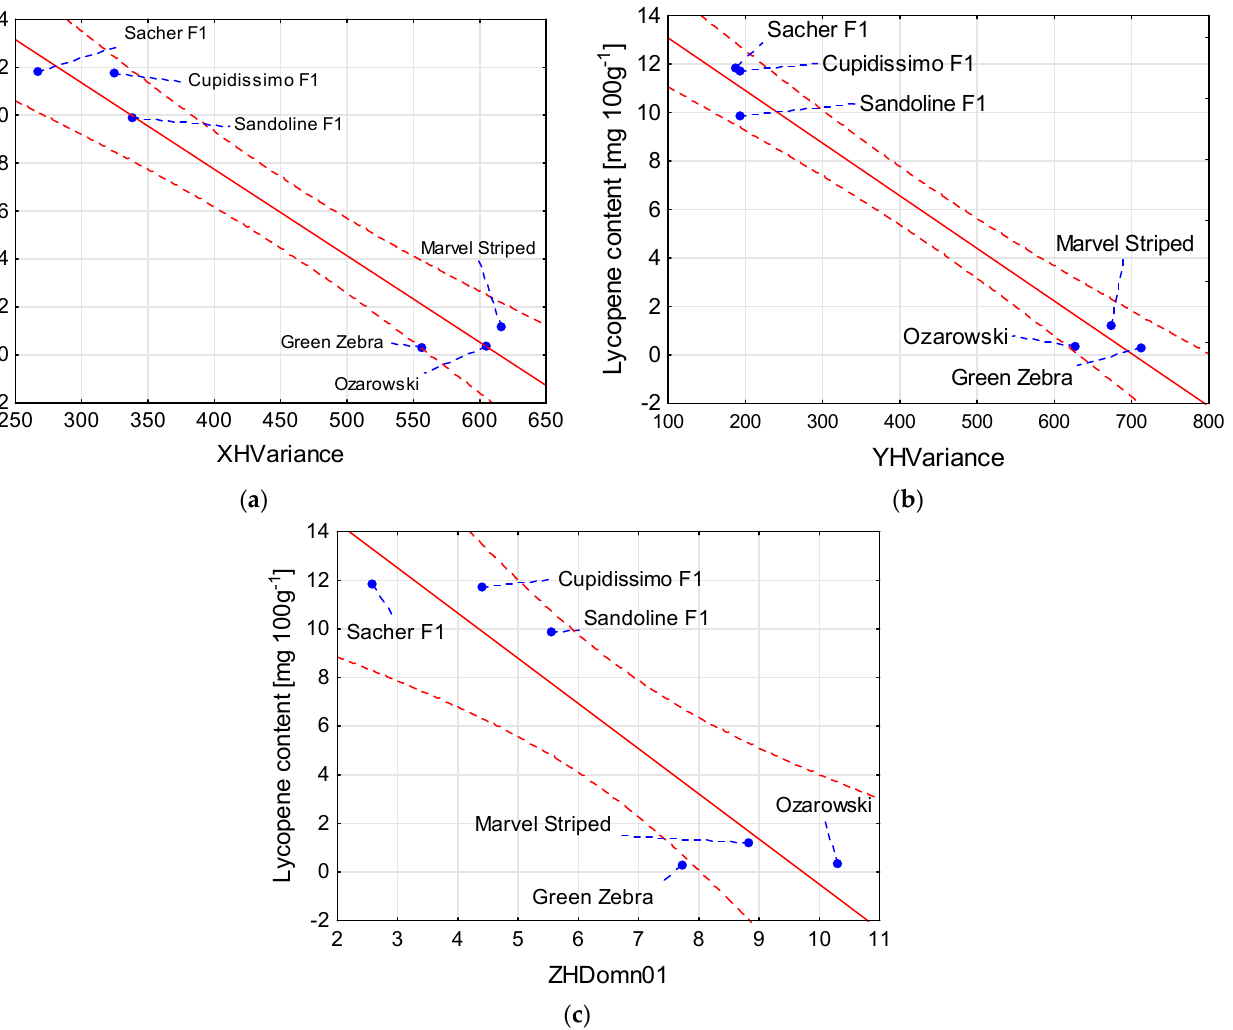
Figure 6. Scatter plots for lycopene content (mg 100 g − 1 ) and selected image textures: XHVariance ( a ), YHVariance ( b ) and ZHDomn01 ( c ) from XYZ color space of tomato fruit. Blue dot—mean value for the sample; blue dashed line—line connecting the mean value to the sample name; solid red line—regression line; red dashed line—confidence interval (95%). Regression equations and coefficients of determination (R 2 ) for relationships between lycopene content and selected texture parameters are presented in Table 5. In the case of individual color channels, one texture with the highest correlation coefficient (Tables 2–4) and providing the highest results of regression equations and coefficients of determination was selected. The R 2 value of 0.99 was reached in the case of texture from color channel G (GS5SV3SumAverg). Additionally, a very high value of the coefficient of determination (R 2 ) equal to 0.98 was obtained for textures from color channels b (bHPerc99) and Y (YHVariance), 0.96—for texture from color channel X (XHVariance), and 0.94—for textures from color channels B (BS4RNGLevNonU) and L (LHPerc99). These indicate a high accuracy for the derived regression equation. Table 5. The regression equations between lycopene content and selected image textures of ‘O ż arowski’, ‘Marvel Striped’, ‘Green Zebra’, Sandoline F1, Cupidissimo F1, and Sacher F1 toma- toes.